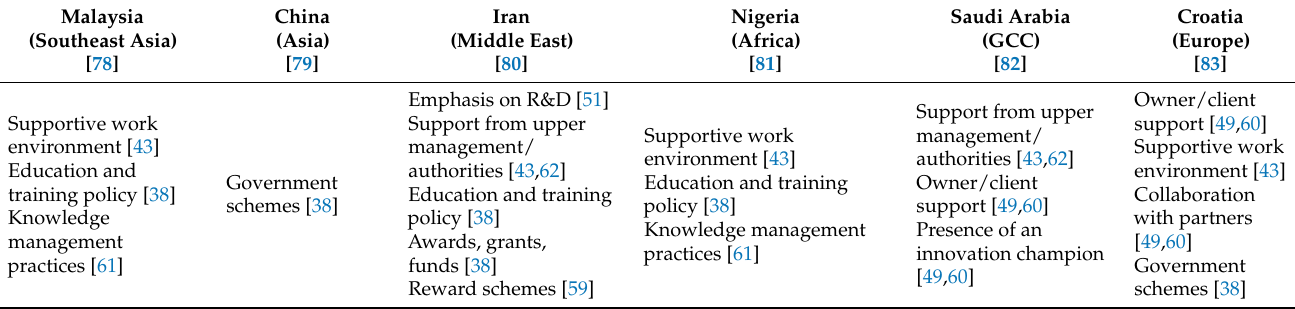
Table 7. Enablers of BIM innovation in developing